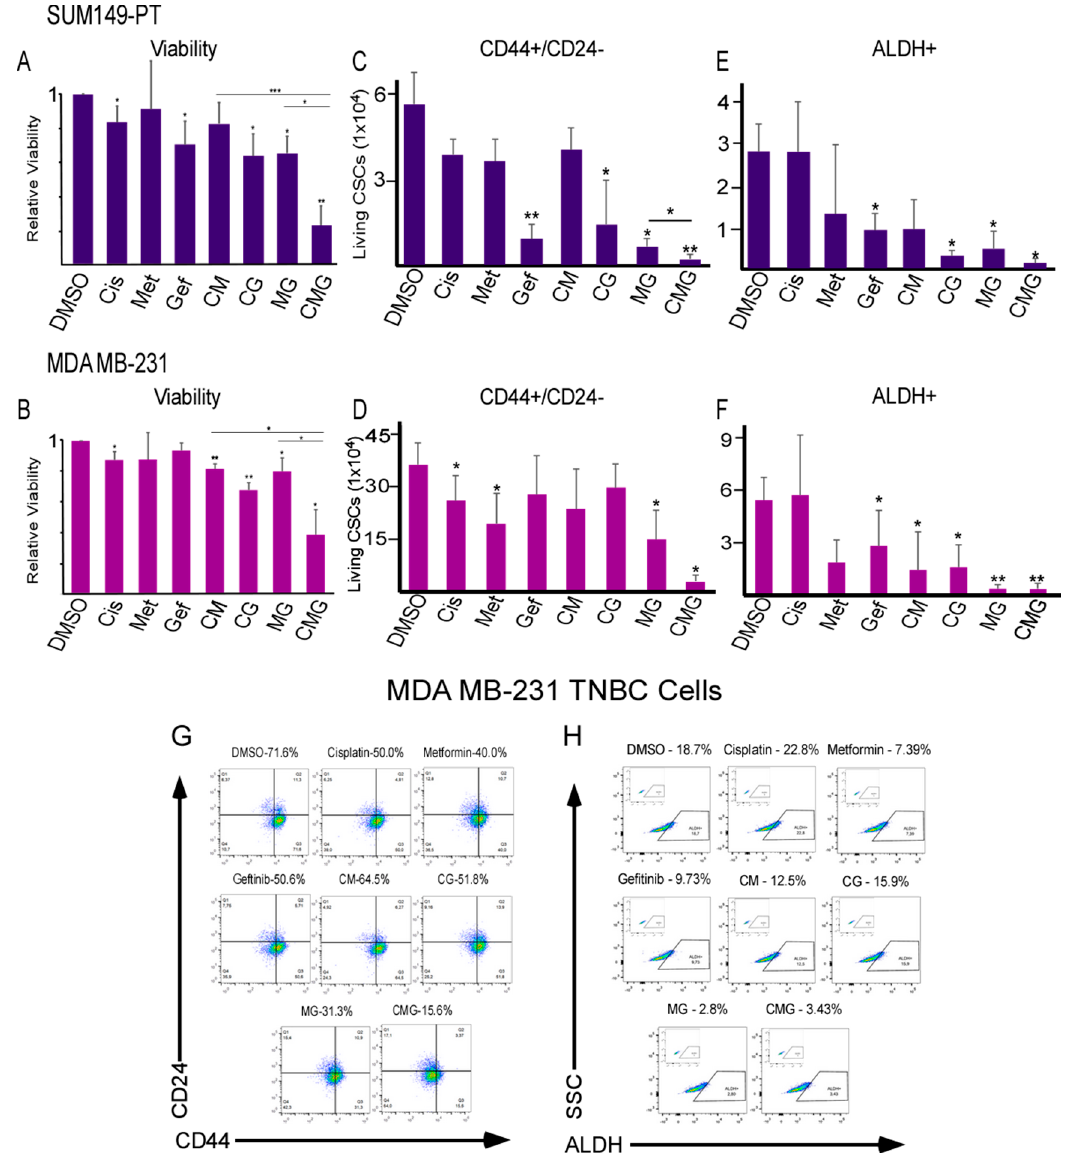
Figure 2. Co-inhibition of hypoxia and EGFR in combination with cisplatin effectively suppress bulk tumor cells and CSC subpopulations in TNBC. ( A ) Relative viability (MTT assay) of SUM 149-PT TNBC cells after 120 h of exposure to DMSO (vehicle control), cisplatin (Cis, 5 µM), gefitinib (Gef, 5 µM) and/or metformin (Met, 25 µM). ( B ) Relative viability (viable cell counting) of MDA-MB-231 TNBC cells after 120 h of the same treatment as described in (A) ( C , D ) Living CSCs (CD44+/CD24 − ) in SUM 149-PT and MDA-MB-231 cells after 120 h of exposure to the drugs as described in (A). ( E , F ) Living CSCs (ALDH+) in SUM 149-PT and MDA-MB-231 cells after 120 h of exposure to the drugs as described in (A). ( G , H ) Representative flow cytometric plots of the CSC subpopulations (CD44+/CD24 − or ALDH+) in MDA-MB-231 cells after 120 h of treatment with the drugs as described in (A). Data represent means ± SD, n = 3 repeats; * p < 0.05, ** p < 0.01, *** p < 0.001.